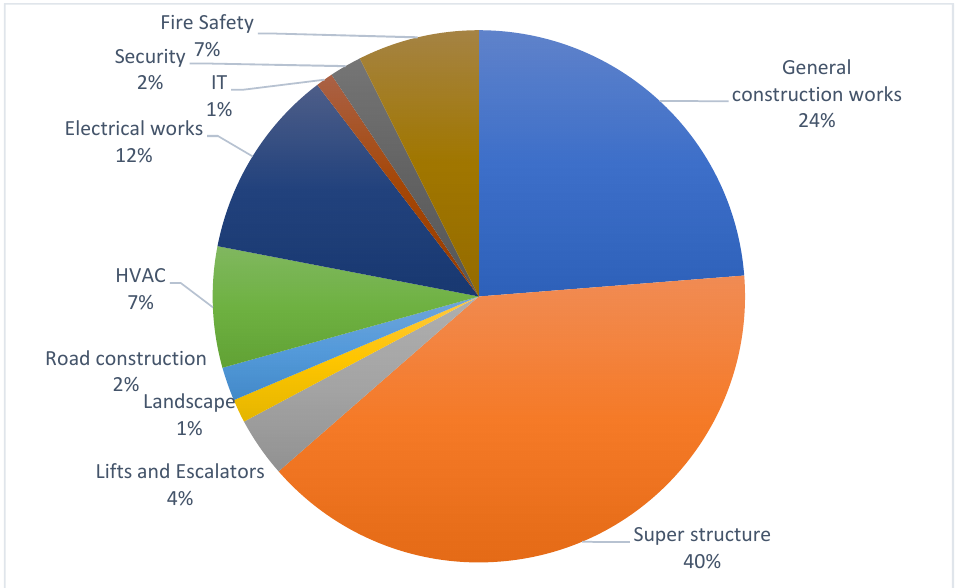
Figure 6. Cost disaggregation by the percentage of the cost of building system for the case study store.